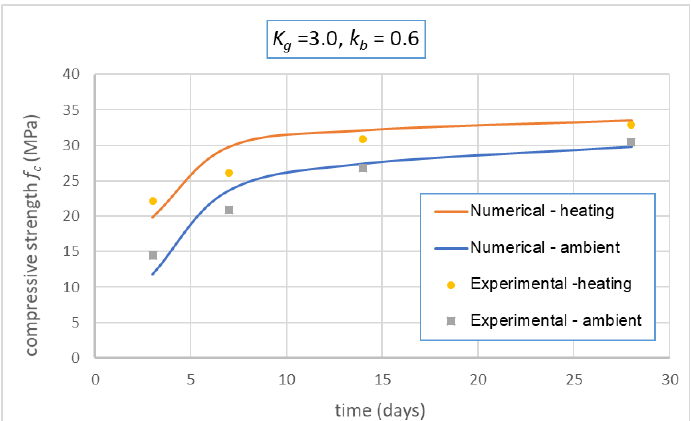
Figure 19. Comparison of experimental and numerical results obtained by Feret’s model for GRAC at different ages.